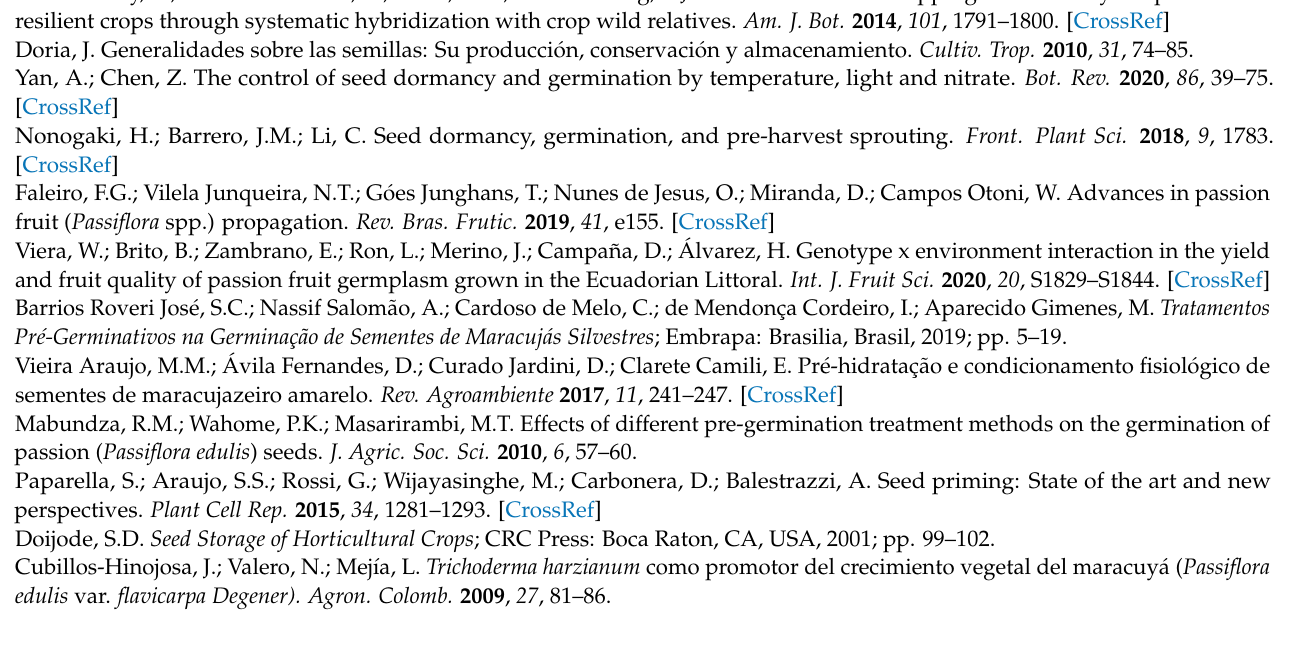
the seedling traits. Figure S1: Seed of five passion fruit genotypes. From left to right (each two seeds): INIAP 2009, P10, POR1 (all P. edulis f. flavicarpa ), Gulupa ( P. edulis f. edulis ), and PICH1 ( P. maliformis ). Figure S2: Different stages of seedling germination of P. edulis f. flavicarpa . The third stage (from the left) represents the emergence of the epicotyl and the fifth stage the developed seedling (germination). Figure S3: Seed imbibition of the five genotypes of passion fruit at 0, 12, 24, 48, and 72 h. M1 = water, M2 = hydrogen peroxide, M3 = potassium nitrate, M4 = PEG 6000, M5 = gibberellic acid. Different letters indicate significant differences ( p < 0.05) using the ANOVA analysis followed by Tukey’s test. Figure S4: Seed moisture of the five genotypes of passion fruit at 0, 12, 24, 48, and 72 h. M1 = water, M2 = hydrogen peroxide, M3 = potassium nitrate, M4 = PEG 6000, M5 = gibberellic acid. Different letters indicate significant differences ( p < 0.05) using the ANOVA analysis followed by Tukey’s test. Figure S5: Seedlings of P. edulis f. flavicarpa (INIAP 2009, left), P. edulis f. edulis (Gulupa, center) and P.1maliformis (POR1, right). Seeds were treated with PEG